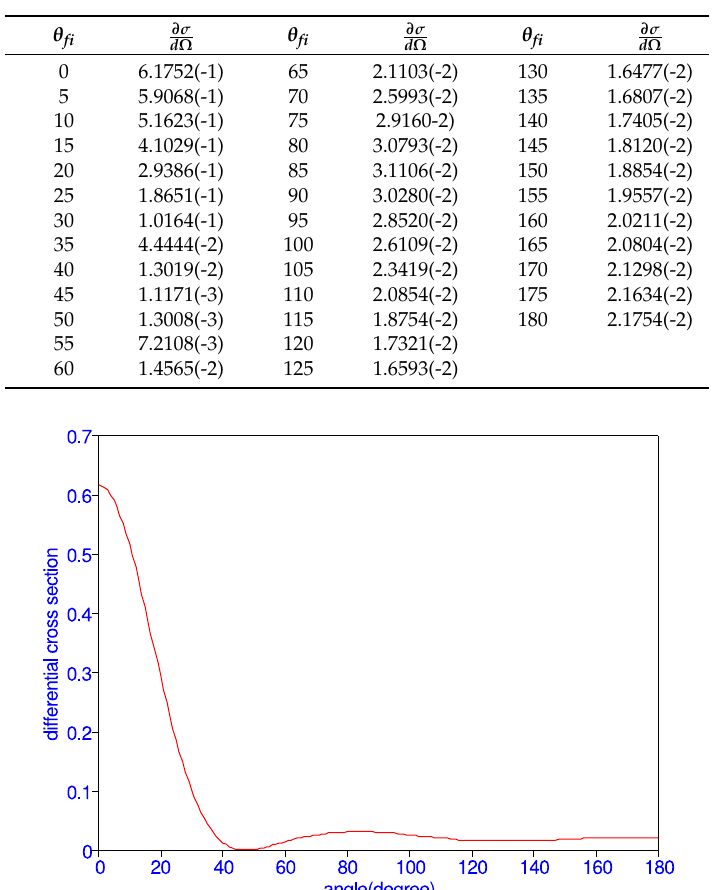
Table 5. Differential cross section ( π a 2